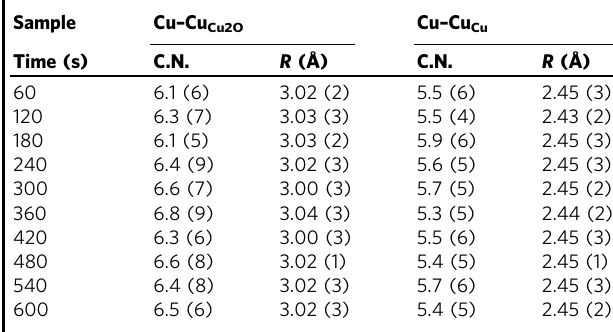
Table 1 Operando EXAFS fi tting parameter for the CuO x at −